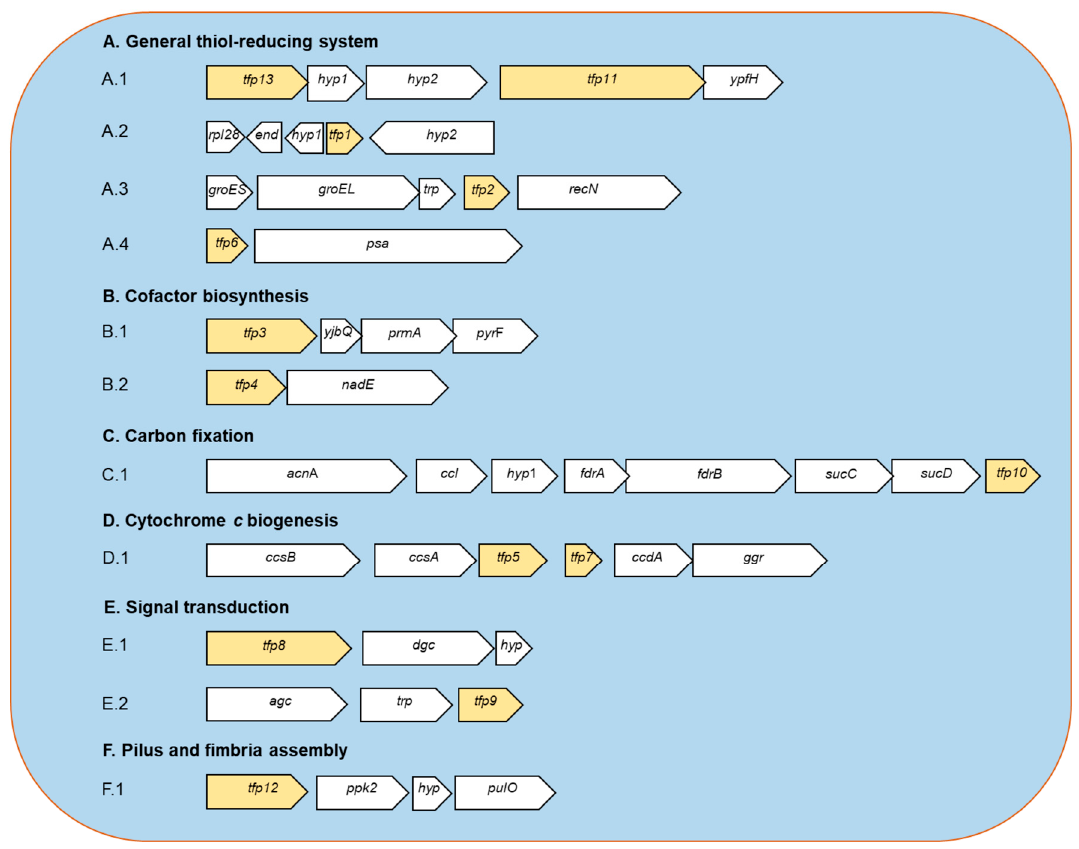
Figure 1. Predicted genetic context of TFP-encoding genes from Leptospirillum sp. CF-1. A.1. The